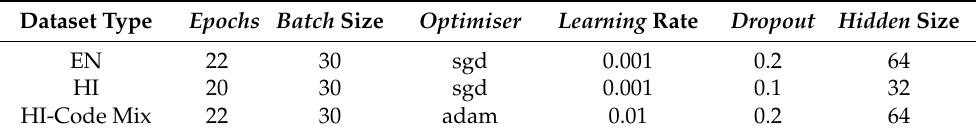
Table 6. Parameter optimisation for CNN LSTM model. Dataset